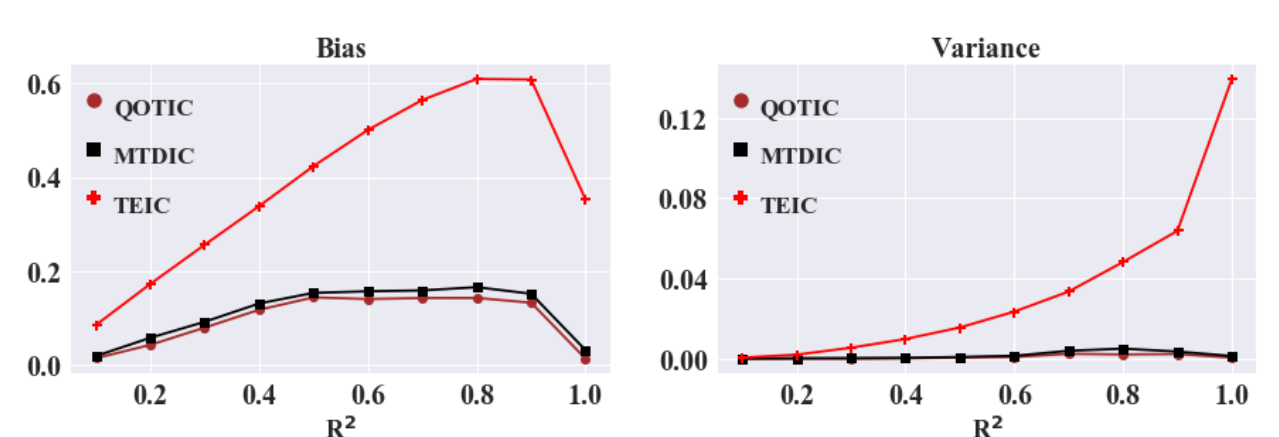
Figure 4. Comparison of bias and variance of QOTIC, MTDIC, TEIC. Figure 3. Comparison of equitability of adaptive equipartition, single optimization and quadratic optimization. Table 1. The color on a relationship and the variable on an axis in Figure 3. Table 2. The analysis of bias and variance of QOTIC, MTDIC, TEIC. Table 2. The analysis of bias and variance of QOTIC, MTDIC, TEIC. Table 2. The analysis of bias and variance of QOTIC, MTDIC, TEIC.